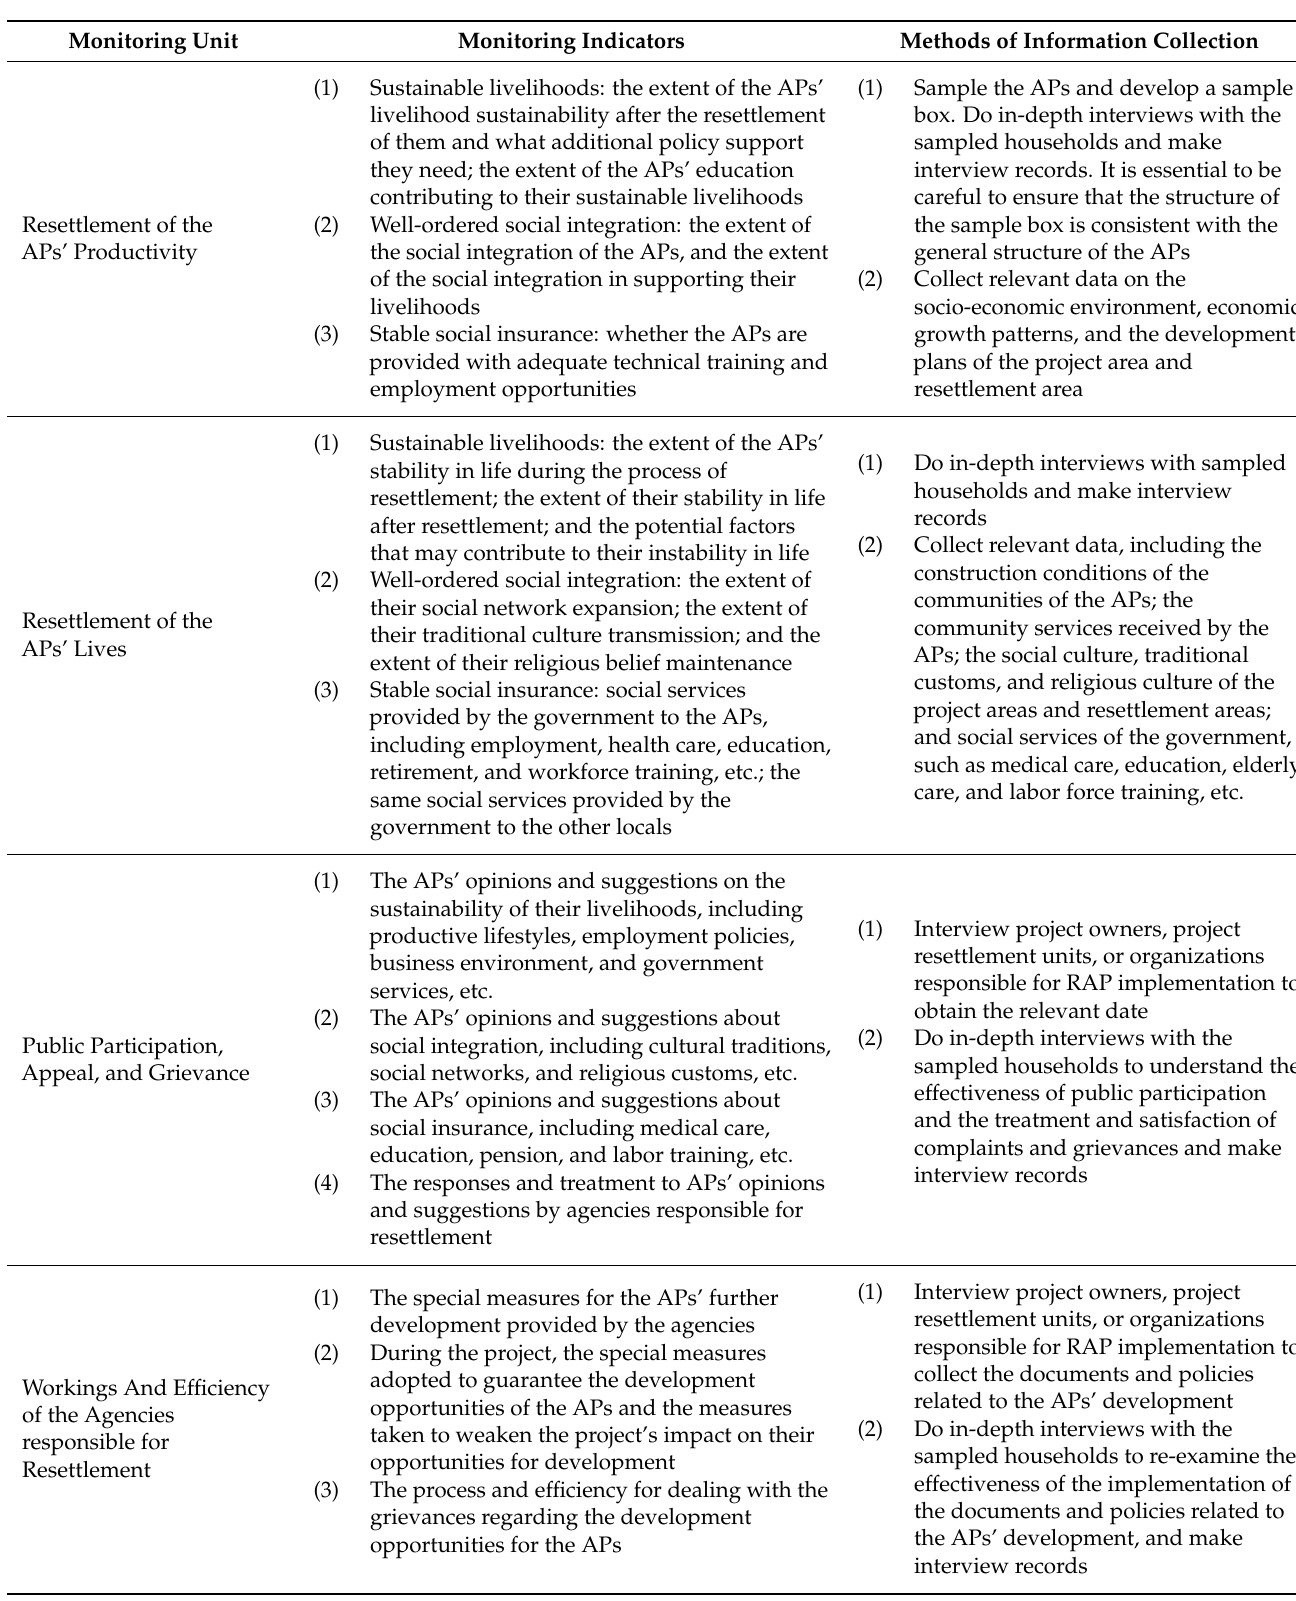
Table 2. Monitoring of the Development of the